Question: Identify the chart type used in this figure.
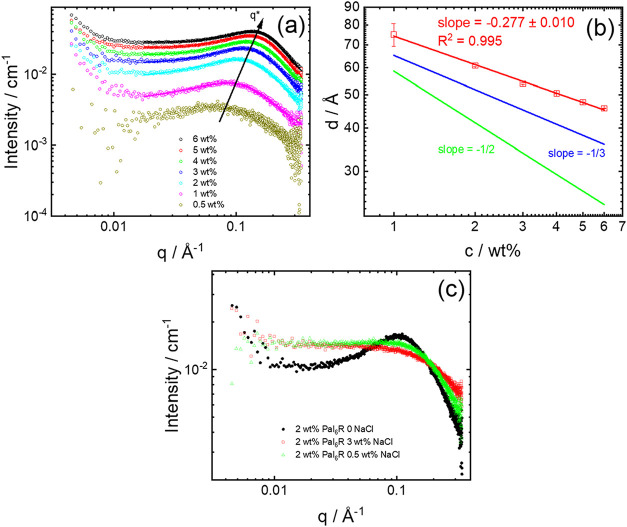
Answer: line